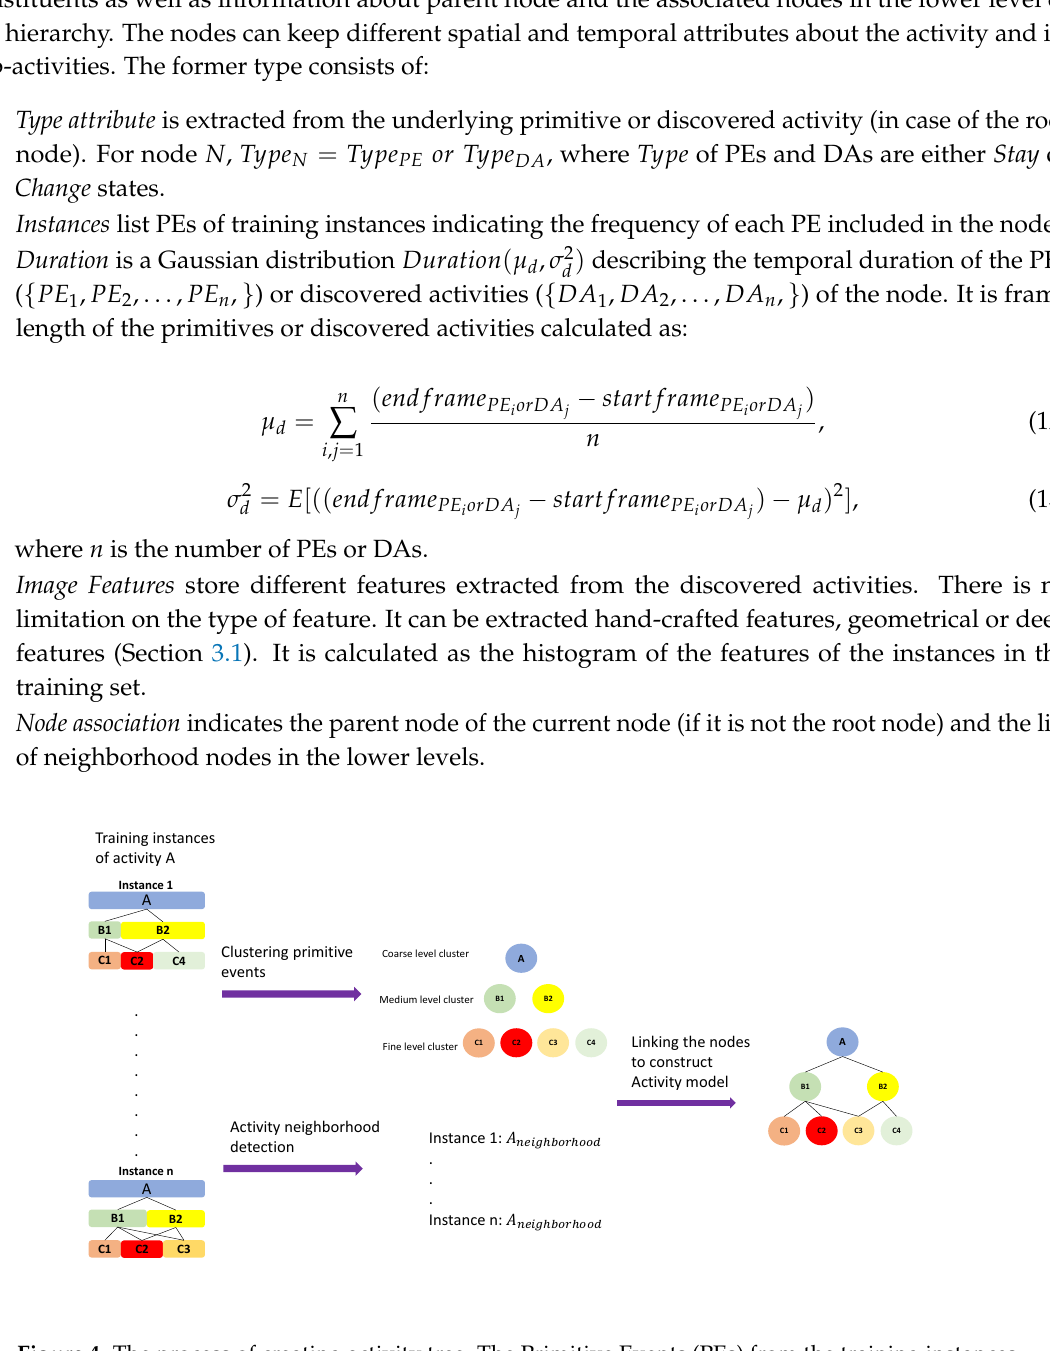
Figure 4. The process of creating activity tree. The Primitive Events (PEs) from the training instances are clustered into nodes and, at the same time, the neighborhood set is detected. The final structure is constructed with those building